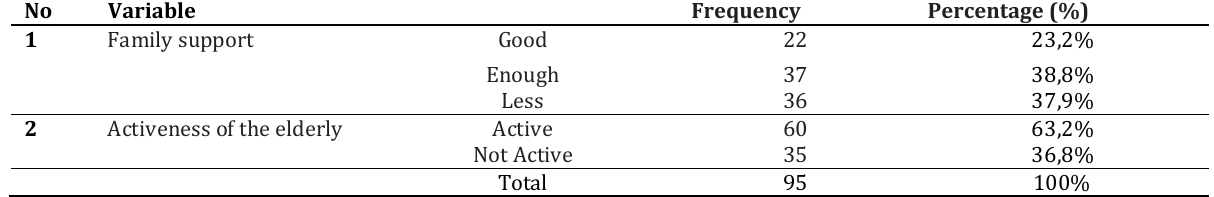
Table 1. Distribution of characteristics based on family support and activeness of the elderly No